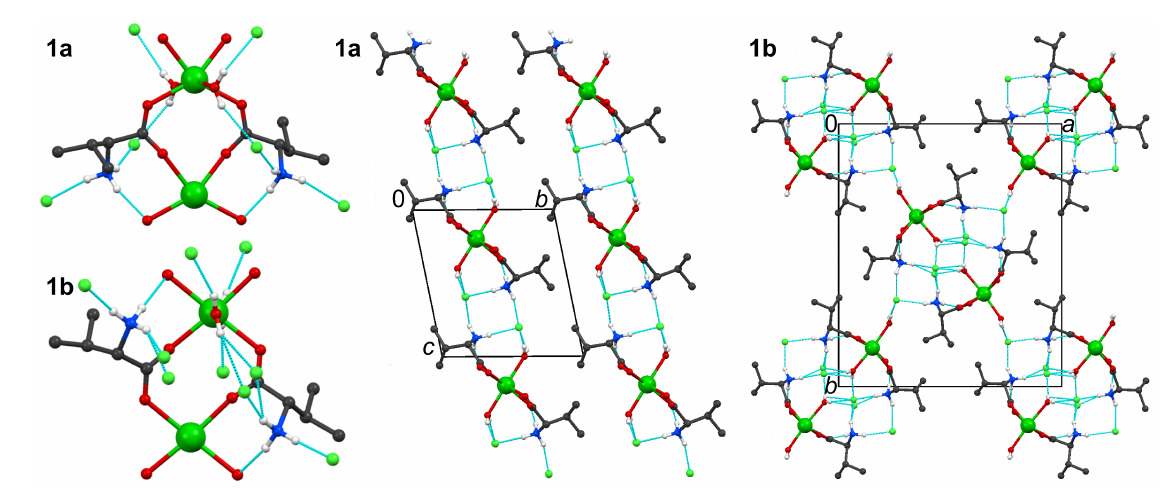
Figure 3. Left: Hydrogen bonds (dashed light blue lines) extending from the asymmetric units of 1a and 1b . Right: Networks built by intermolecular hydrogen bonds in 1a and 1b